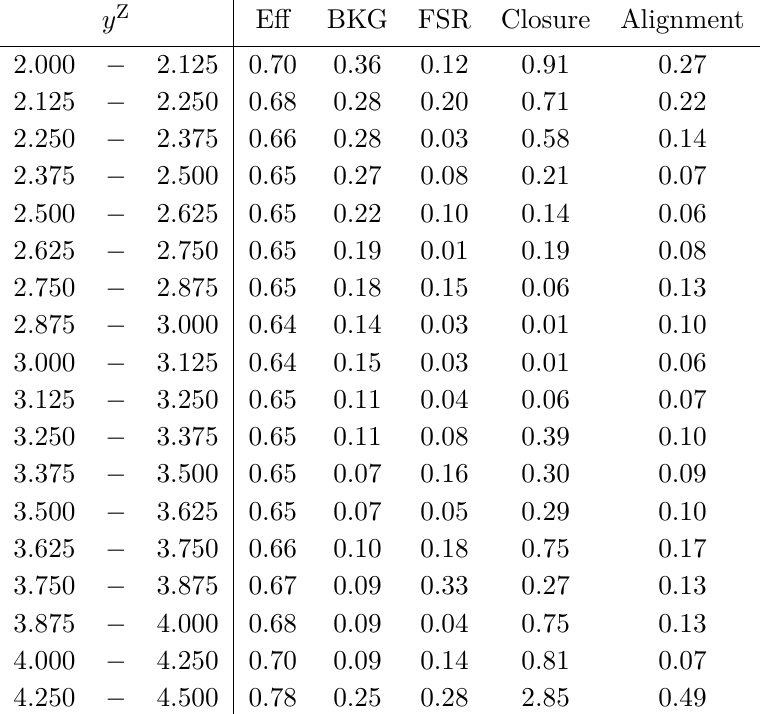
Table 19 . Systematic uncertainties in the single differential cross-sections in interval regions of y Z , presented in percentage. The contributions from efficiency (Eff), background (BKG), final state radiation (FSR), closure test (Closure), and alignment and calibration (Alignment) are shown.